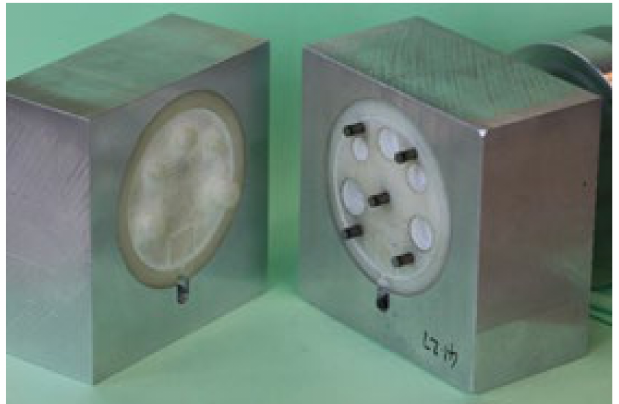
Figure 4. Core and cavity 3DIM inserts assembled inside a MUD base along with ejector pin assembly. The white parts are the 3DIM tools and the aluminium housings are the MUD